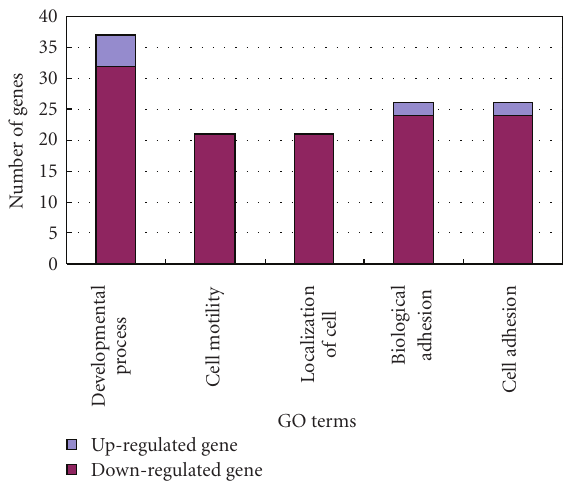
Figure 3: Functional analysis of the 65 important genes in the focal adhesion pathway using GOstat, in which five GO terms were identified to best describe the functional disorders associated with these 65 important genes, including developmental process, cell motility, localization of cell, biological adhesion, and cell